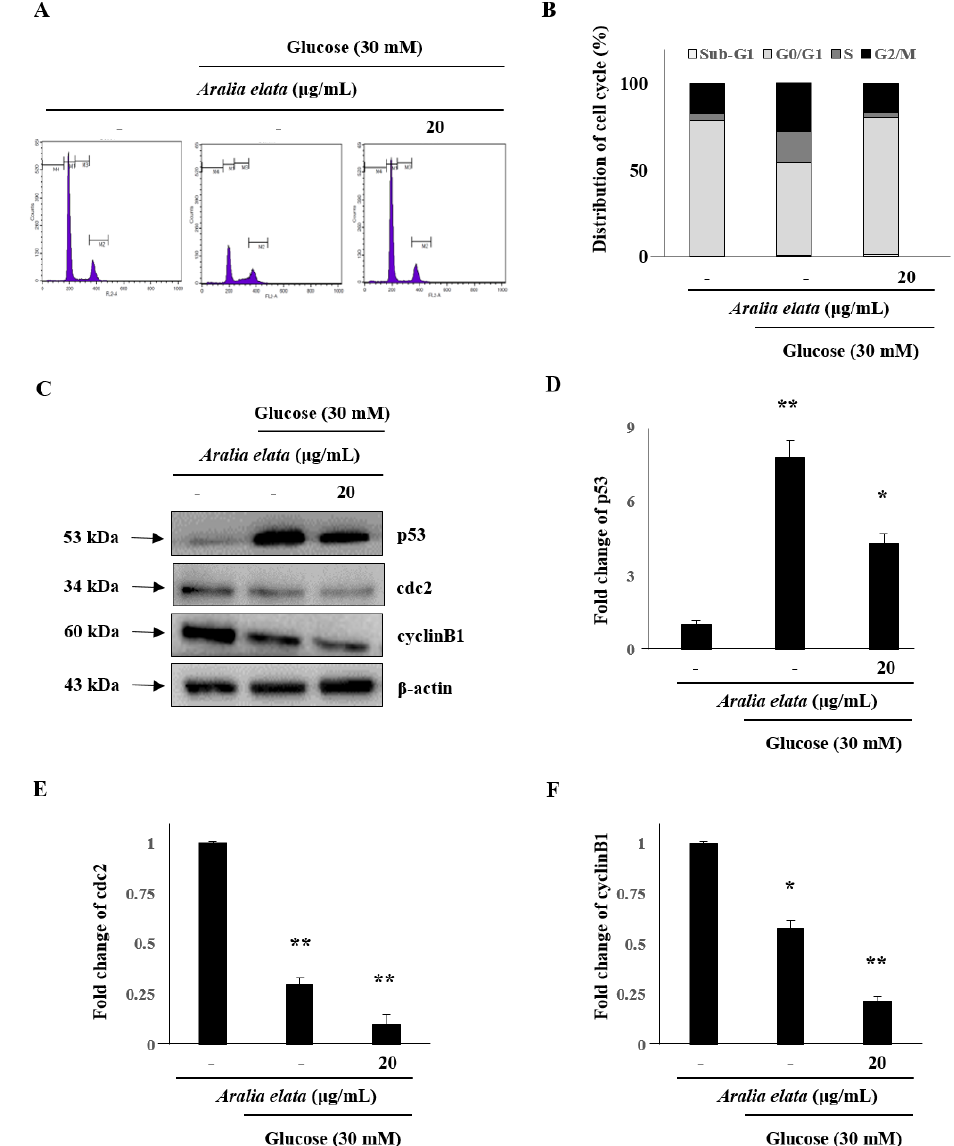
Figure 5. Effect of AS on cell cycle distribution in HUVECs. ( A ) Representative fluorescence-associated cell sorting plots describing cell cycle phases. ( B ) Percentage of cells in different cell cycle phases after HG and AS treatment. Data represent the mean ± SD of five independent experiments. ( C ) Western blot analysis of p53, cdc2, and cyclin B1 levels. ( D – F ) Quantification of p53, cdc2, and cyclinB1 levels relative to β -actin. * p < 0.05; ** p < 0.01 vs. the control group.